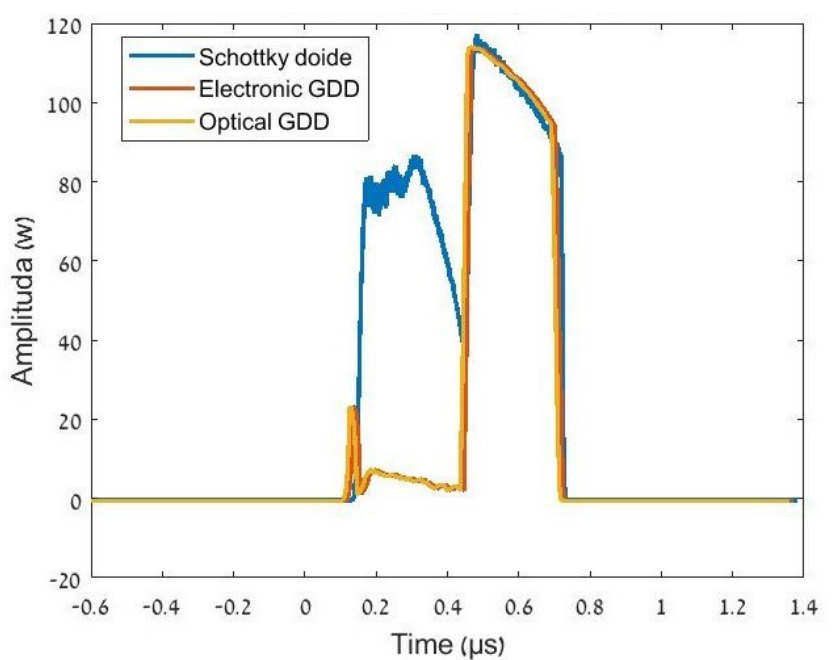
Figure 5. Comparison between Schottky diode and glow-discharge detector (GDD) respected the frequency